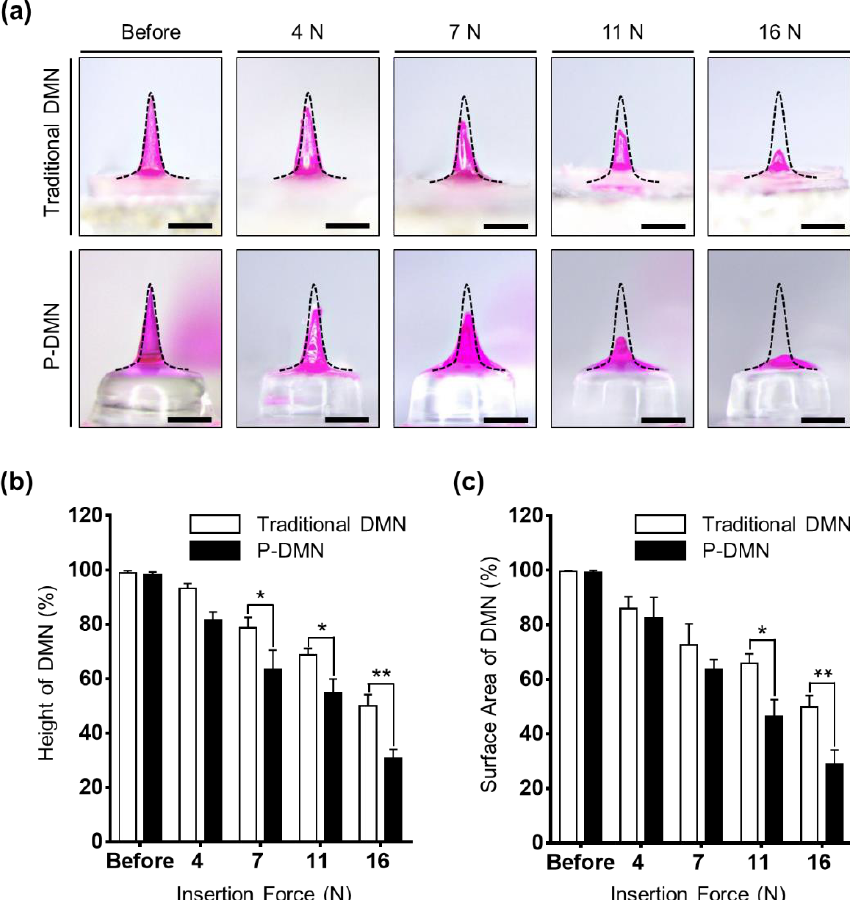
Figure 3. Effect of application force on dissolution of dissolving microneedles (DMNs). ( a ) Comparison of a traditional DMN and a micro-pillar integrated DMN (P-DMN) post-application. Increasing the application force led to increased dissolution of DMNs in both groups. ( b ) Height of DMNs post-application. Increasing the application force from 4 to 16 N reduced the height of the DMNs. ( c ) Surface area changes of the DMNs applied onto the skin at different forces. Similar to the height, the area of DMNs was reduced by increasing the application force. Scale bars in (a) are 500 μm. * p < 0.05 and ** p < 0.01.